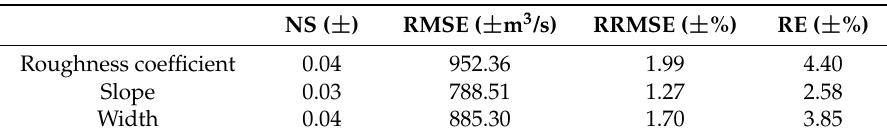
Table 5. Estimated resultant errors associated with the roughness coefficient, slope and width parameters using Equation (4) at virtual station